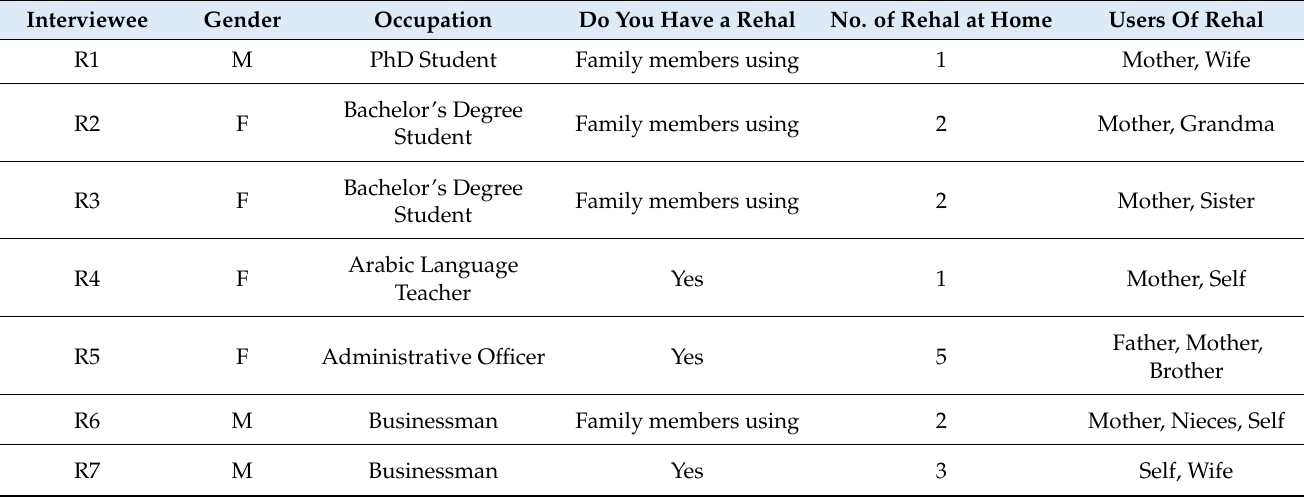
Table 1. Compilation of interviewees’